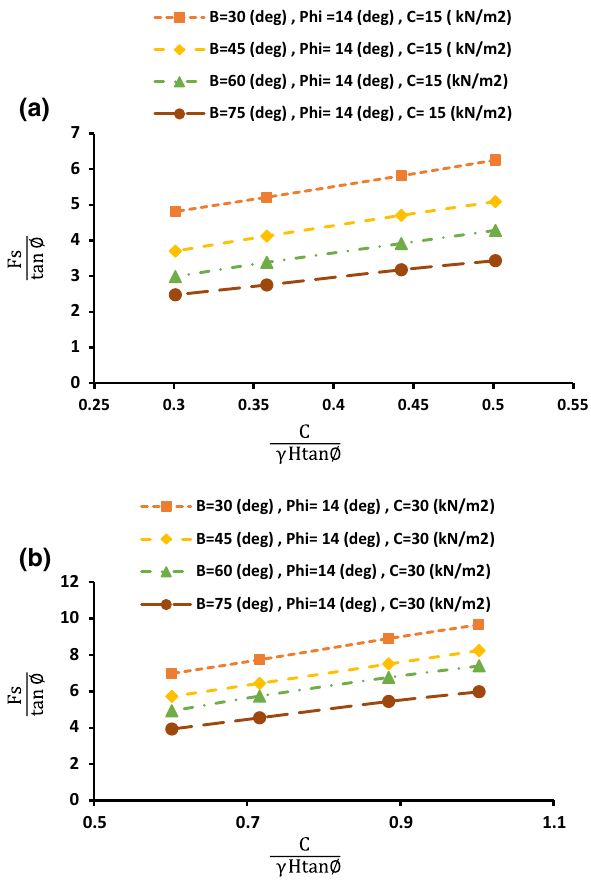
Fig. 6 The boundaries of the potential slip circle slope relative to the slope angle Fig. 4 The effect of slope materials on the factor of safety for the ◦ and C = 25 kN/m 2 ◦ and C = 30kN/m 2 state. a � = 14 and b � = 14